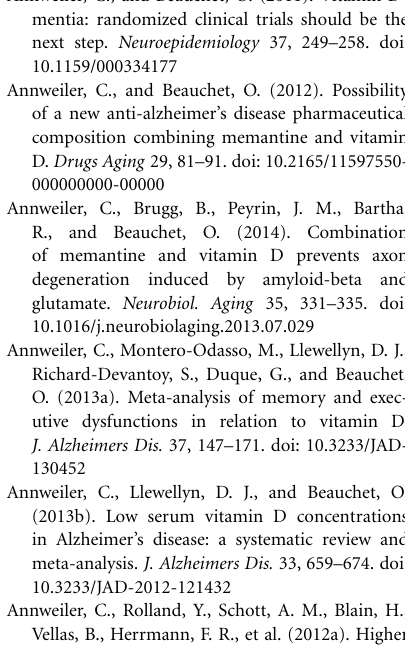
to cultures enriched with memantine